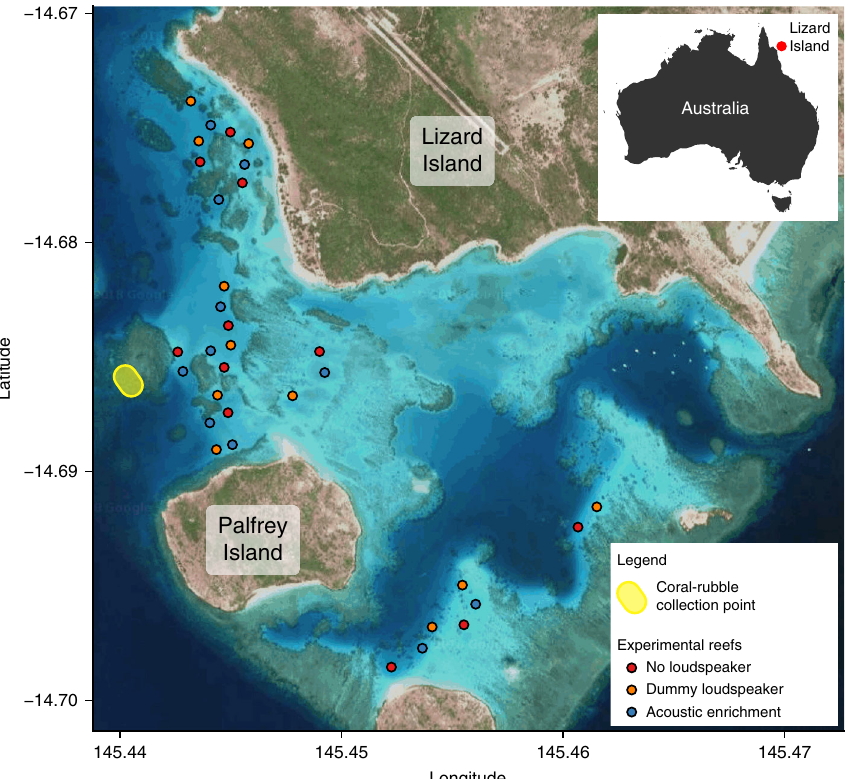
Fig. 5 Study site map, showing experimental reefs and coral-rubble point. All experimental reefs were placed at a minimum distance of 100 m from their nearest neighbour, and at a fi xed distance of 25 m from the nearest natural reef. Satellite image obtained from Google Maps, available at https://goo.gl/ maps/5Loa45HKYgJ2 (Map data: Google, GBRMPA).